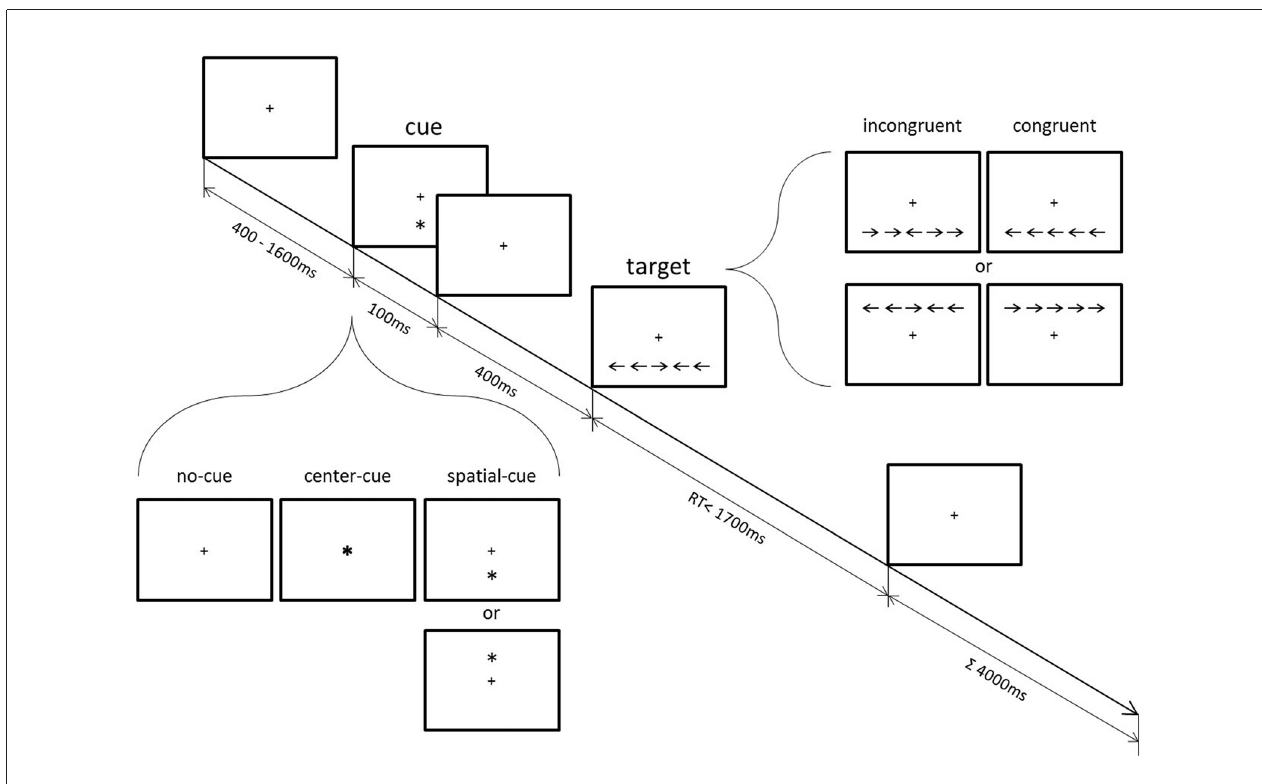
FIGURE 1 | Schematic diagram of the attention network test (ANT; modified from Jo et al.,